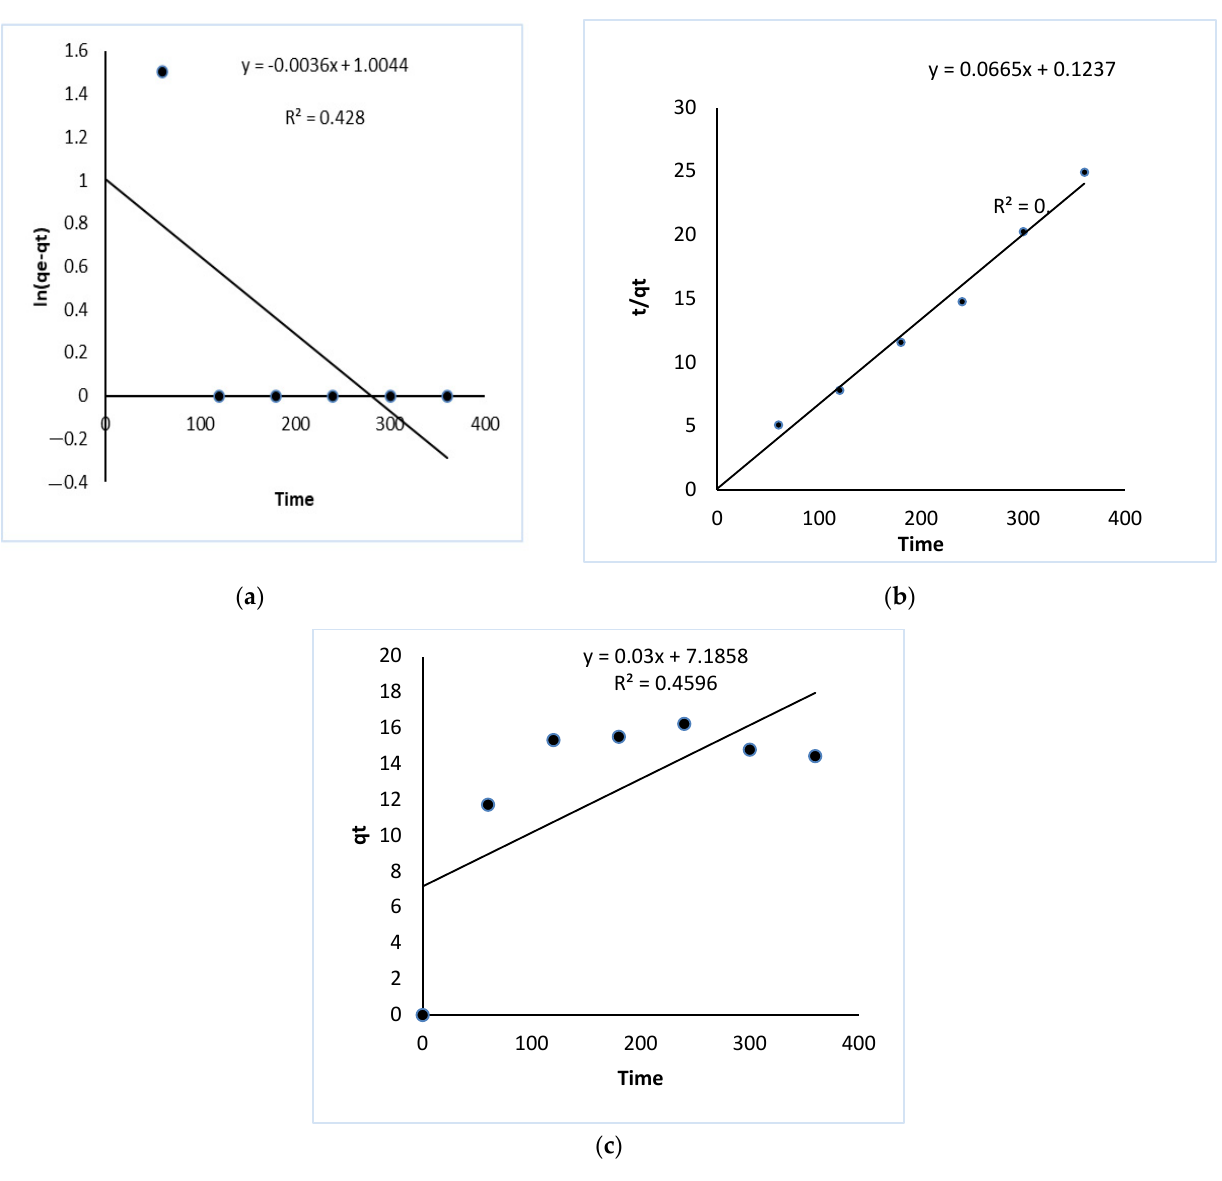
Figure 6. ( a ) Pseudo first-order, ( b ) pseudo second-order, and ( c ) Weber–Morris intraparticle diffusion models for adsorption of PB dye by PFPB.